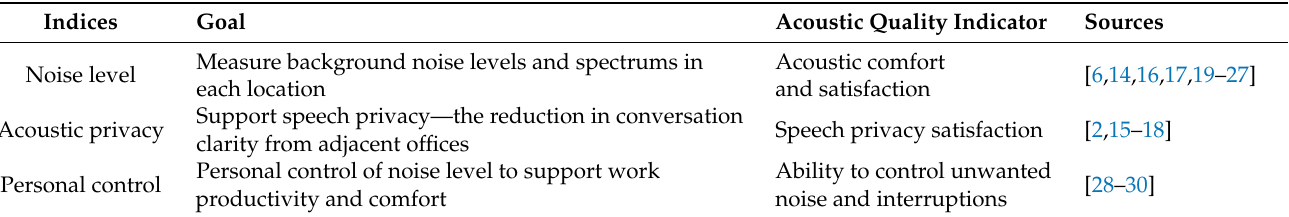
Table 1. Indicators of indoor acoustic quality assessment.